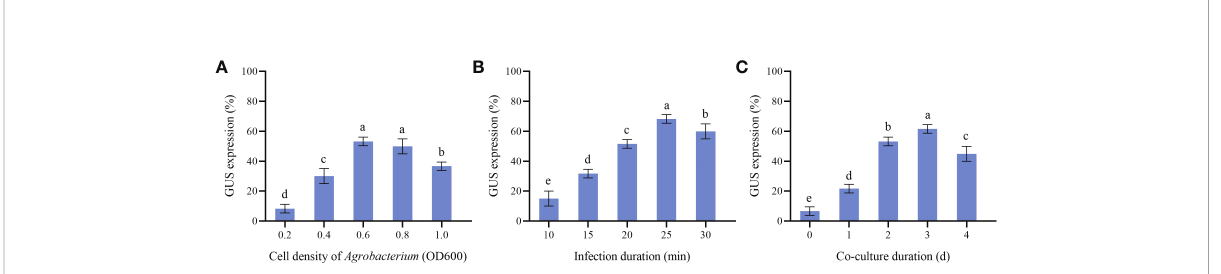
FIGURE 6 Parameters affecting transformation ef fi ciency. (A) GUS expression at different Agrobacterium cell density, (B) GUS expression at different Infection duration, (C) GUS expression at different Co-culture duration, the different letters within a column marked signi fi cant differences (p <